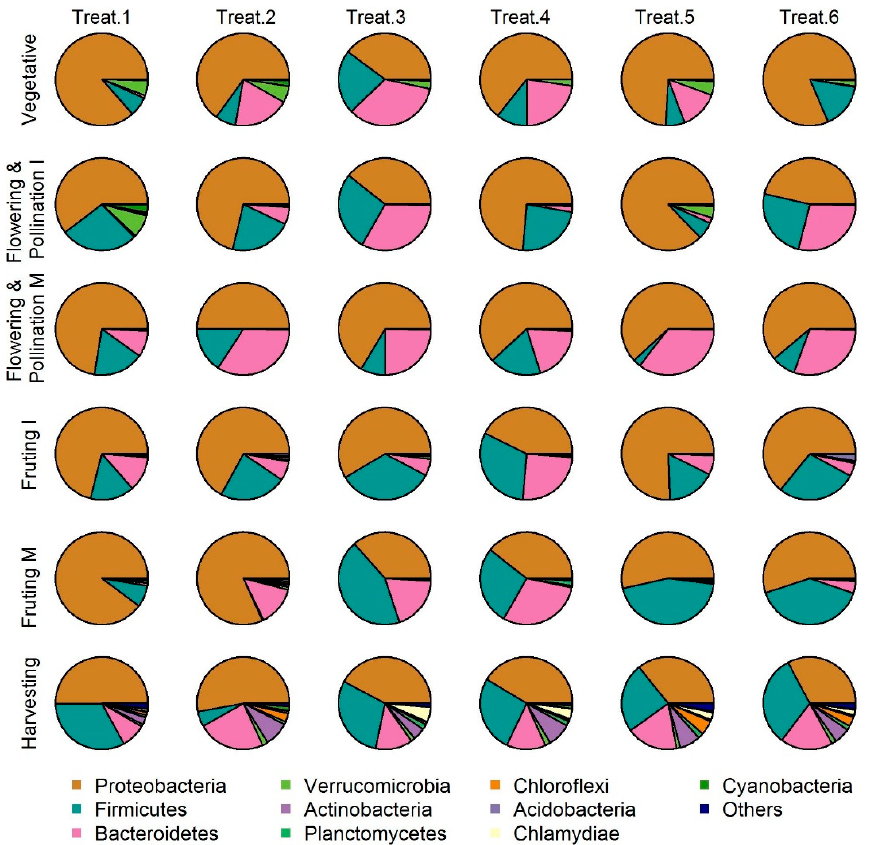
Figure 4. Change in dominant rhizosphere bacterial taxa at the phylum level across different nutrient treatments and melon growth stages. The data on fungal taxa can be found in Supplementary Material (Figure S1).